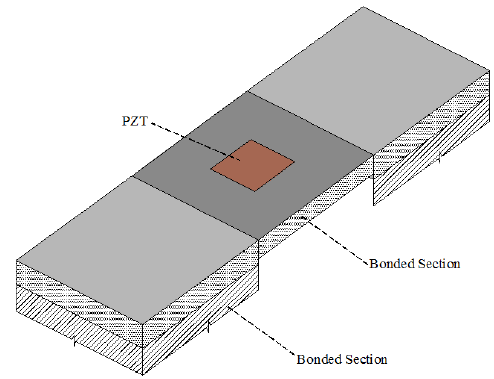
Figure 4. Prototype of PZT interface [27].